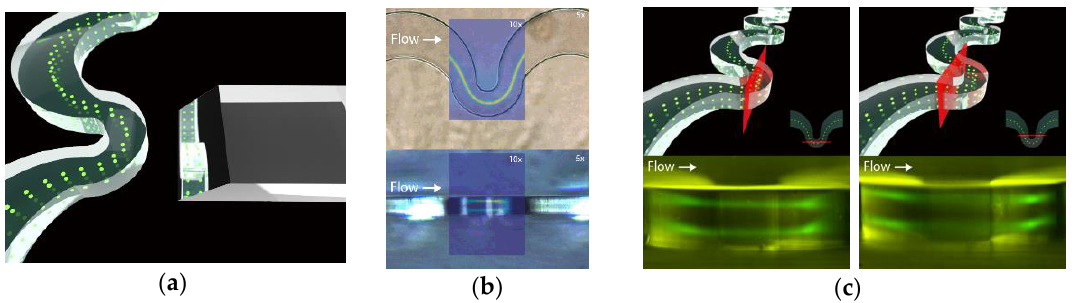
Figure 1. ( a ) Render that illustrates the position of the lateral mirror with respect to the serpentine; ( b ) Zenithal (top) and lateral (bottom) views of the serpentine with an overlapped fluorescence streak image (false color) from inertially focused particles at a flow rate of 130 μL/min; ( c ) The limited depth of field of the employed objective allows the streak of particles reflected in the mirror to focus on different focus planes (red planes).